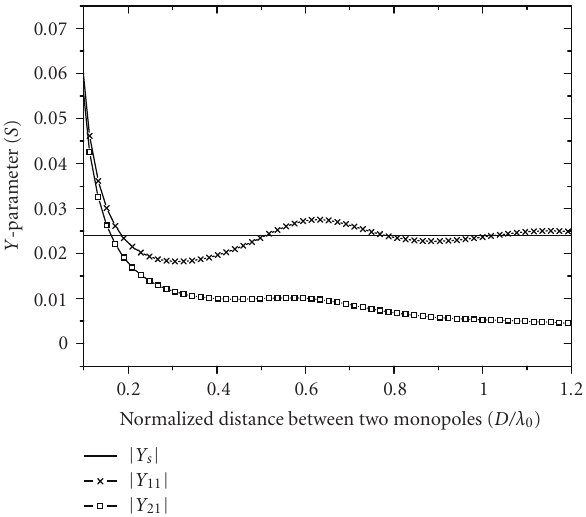
Figure 9: The e ff ect of the monopole distance on the Y -parameters of the two-monopole antenna ( f = 937 . 5 MHz).